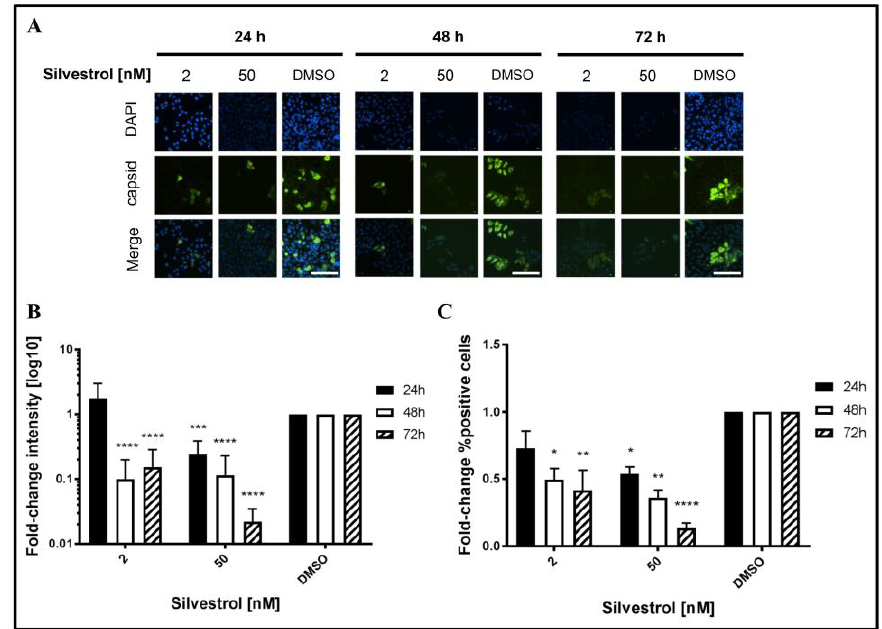
Figure 5. Immunofluorescence staining of silvestrol-treated A549 cells persistently infected with HEV strain 47832c. ( A ) Persistently HEV-infected A549 cells were seeded on cover-slips and treated with respective concentrations of silvestrol for the indicated time points. Nuclei were stained using 4′,6-Diamidin-2-phenylindole (DAPI) (blue) and an anti-HEV capsid protein (core) antiserum (green), scale bar =50 µ m ( B ) Fluorescence intensity quantification of HEV capsid protein immunostaining and referred to the respective DMSO control to gain fold-change; and, ( C ) Comparison of the proportion of HEV capsid protein expressing cells depicted in Figure 5A referred to the respective DMSO control. n = 4 for all experiments; * p < 0.05, ** p < 0.01, *** p < 0.001, **** p <